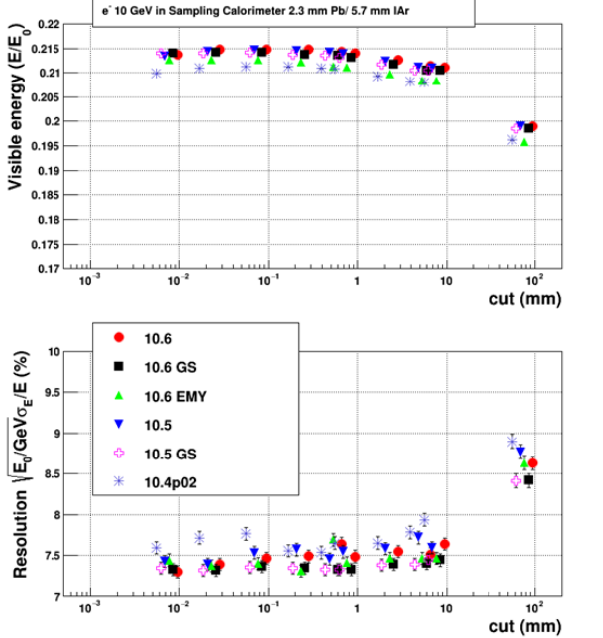
Fig. 2. Simulation of the response of simplified ATLAS type EM calorimeter for 10 GeV gamma as a function of cut in range (Geant4 tracking parameter, see description in [1, 3]) for different Geant4 versions from 10.4 to 10.6: top - visible energy, bottom – resolution. GS is the EM physics configuration where the default MSC model for e ± is substituted by the Goudsmit-Saunderson model [7]. EMY is the EM physics configuration used for medical and other low-energy applications. For this type of calorimeter for cut value 1 mm, in Geant4 10.5 and 10.6 compared to 10.4 visible energy increases by 1.5% and resolution decreases by 1.5%.